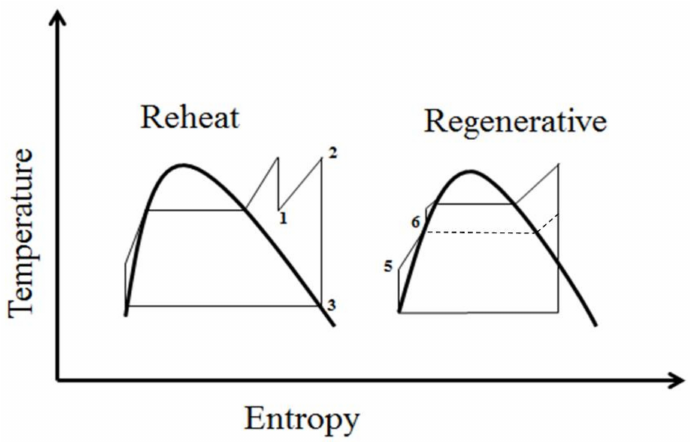
Figure 2. Representation of the ( left ) reheat cycle and ( right ) regenerative